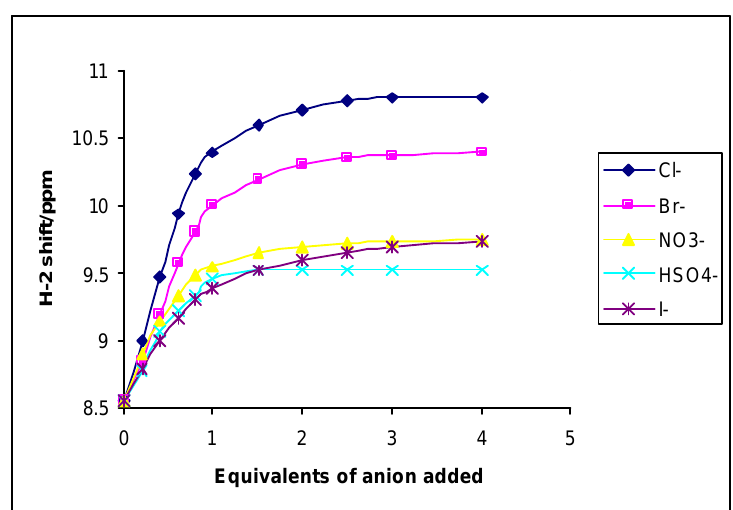
Figure 1 . 1 H-NMR titration curves of the receptor 6 with